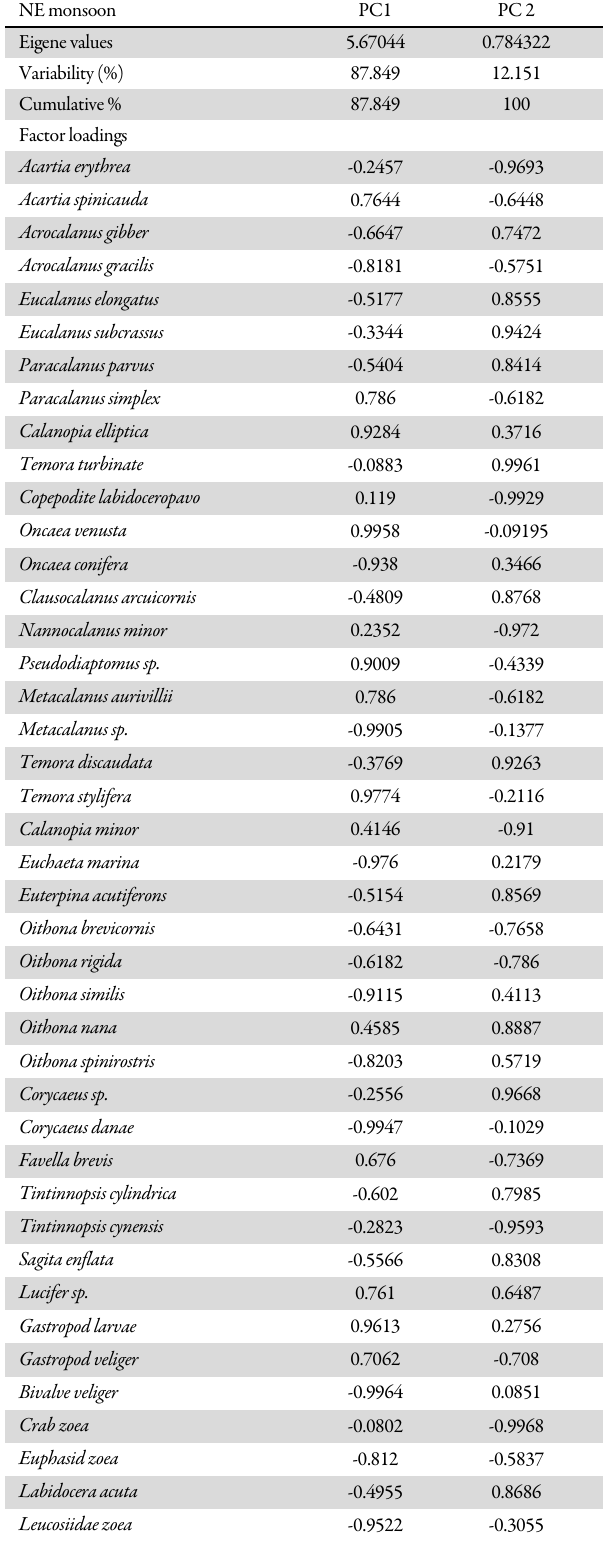
Table 4. Eigene analyses of the correlation matrix loadings of the significant principal components in NE